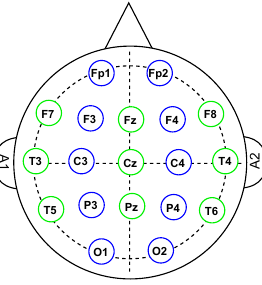
Figure 2. Channels’ spatial location on the skull in making the referred dataset. According to the 10–20 system, uppercase letters define the brain cortex where an electrode is placed. F for Frontal, T for temporal, P for parietal, and O for occipital cortex. The lowercase ”z” is utilized to locate electrodes on the skull’s longitudinal axis. A1 and A2 mean left and right reference voltage electrodes, respectively.